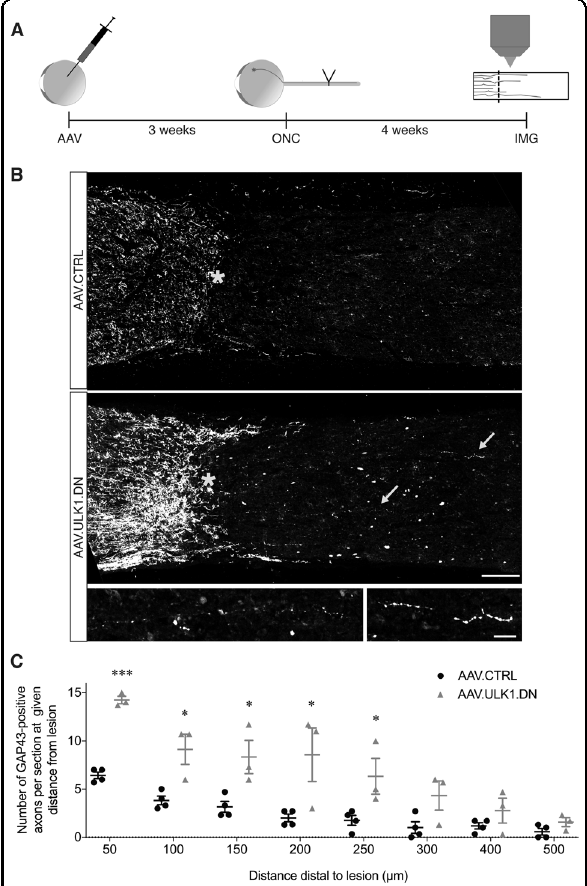
Fig. 3 AAV.ULK1.DN enhances axonal regeneration in the optic nerve. A Scheme of experimental setup. AAV vectors were intravitreally injected 3 weeks before ONC. Four weeks after ONC, the number of GAP43-positive regenerating axons at different distances from the crush site was quanti fi ed on longitudinal optic nerve sections. AAV: transduction with adeno-associated viral vectors; ONC: optic nerve crush; IMG: imaging. B Representative images of longitudinal optic nerve sections transduced with given AAV after immunostaining for GAP43. The crush site is marked with an asterisk. The proximal end of the optic nerve is located on the left, the distal end on the right. Insets at the bottom show higher magni fi cation of single GAP43-positive axons distal to the crush site indicated by arrows in the AAV.ULK1.DN group. Scale bar: 100 μ m; scale bar inset: 20 µm. C Quanti fi cation of the number of GAP43-positive axons at different distances distal to the crush site after transduction with AAV. CTRL ( n = 4 animals) or AAV.ULK1.DN ( n = 3 animals). Data are presented as single data points and means ± SEM. * P < 0.05, *** P < 0.001, according to two-tailed unpaired t -test for each